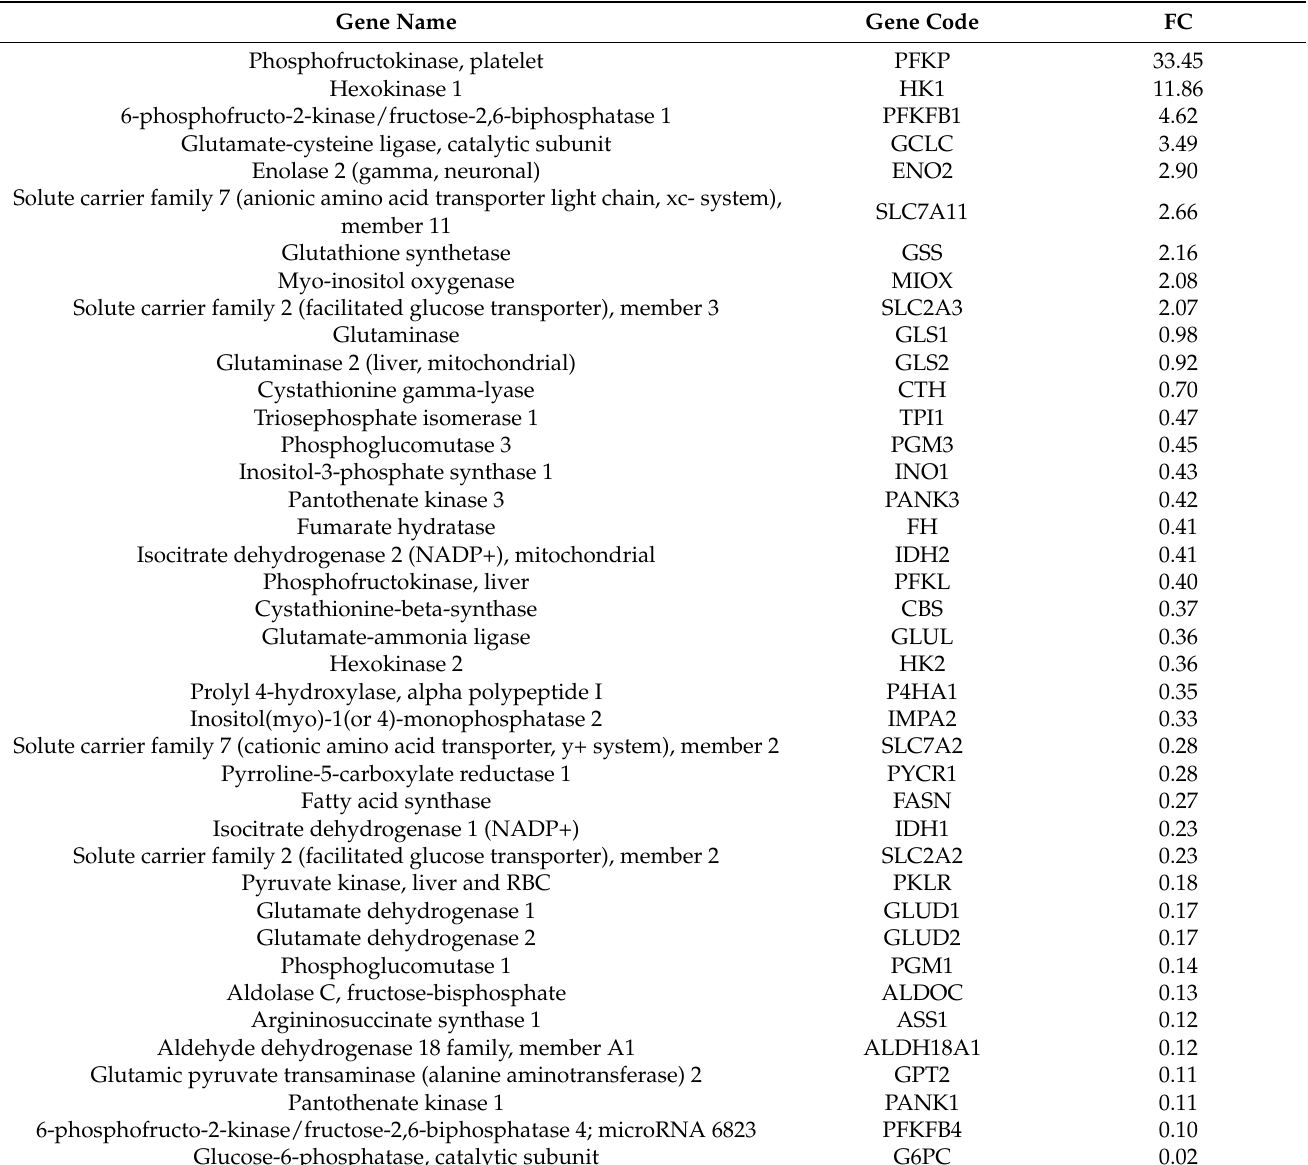
Table 2. Altered transcripts found in HepG2 cells exposed to 5 µ g/mL of AgNPs for 72 h by the transcriptome